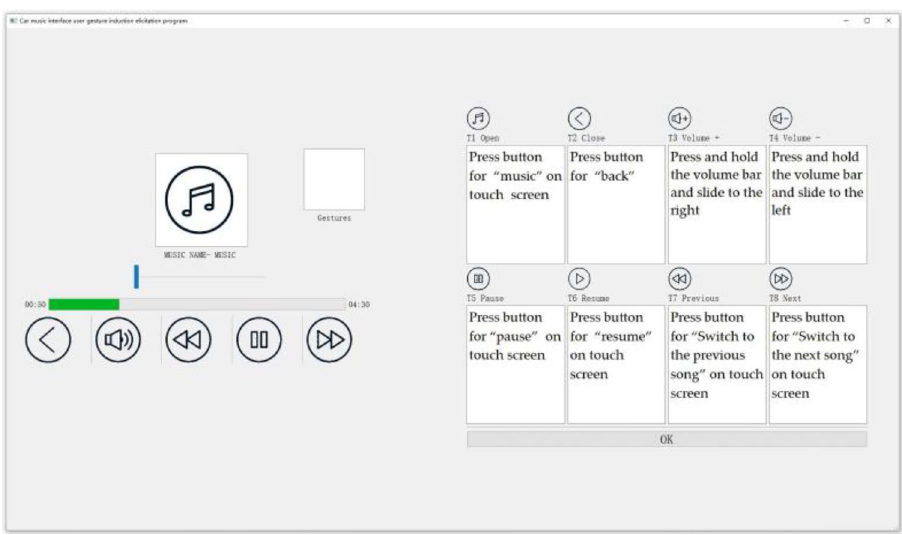
Fig. 3 The prototype interface of user elicitation